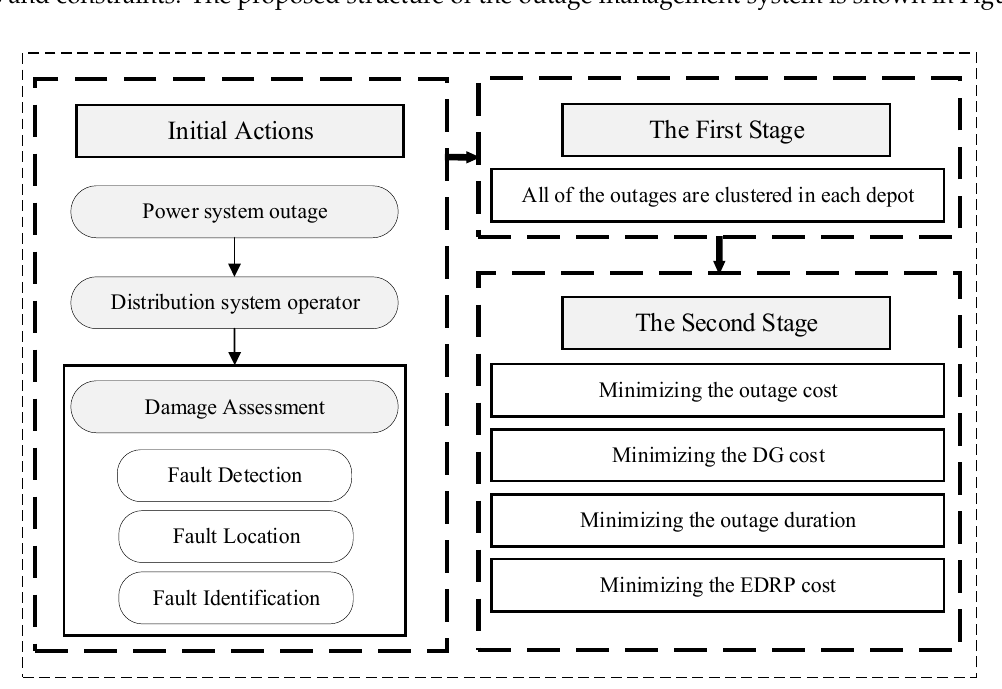
Figure 2. The proposed structure of the system outage management.